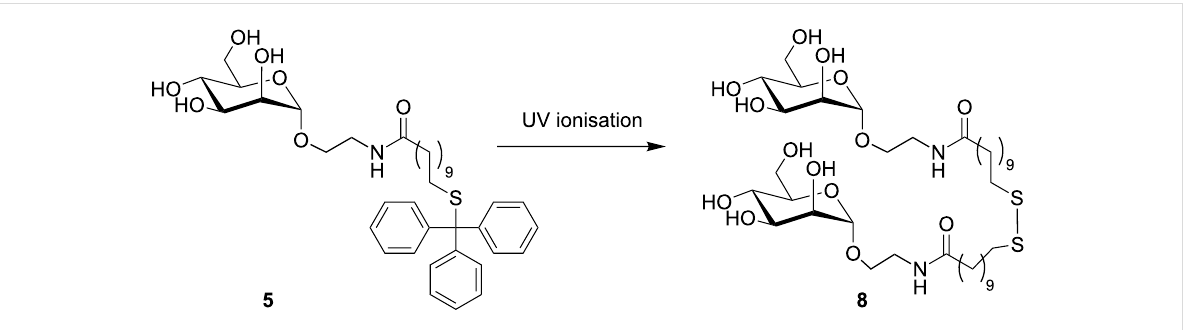
Scheme 2: The Man–Trt compound 5 forms the disulfide 8 during UV ionisation in MALDI-TOF MS